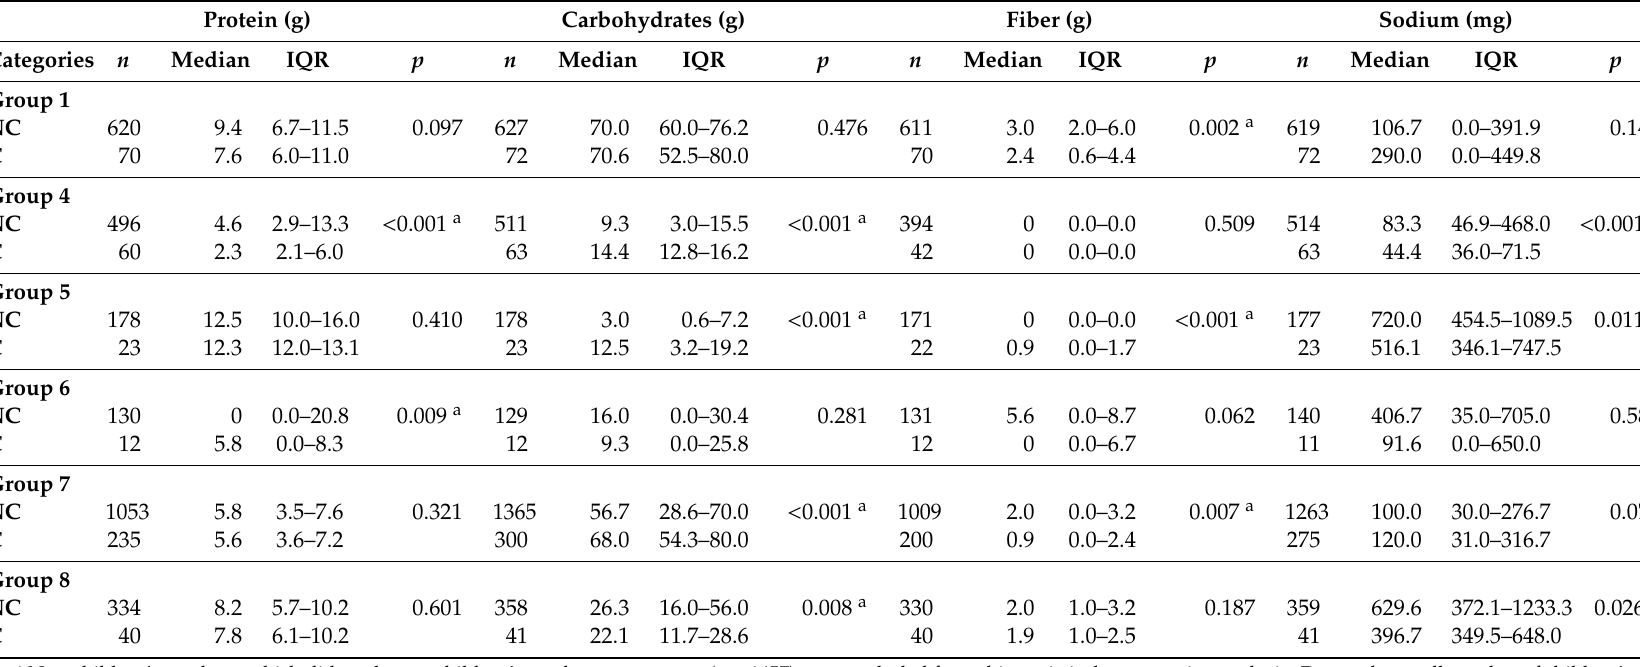
Table 4. Comparison of protein, carbohydrate, fiber, and sodium content per 100 g children’s (C) ( n = 535) and non-children’s (NC) ( n = 3628) food products.* Protein (g) Carbohydrates (g) Fiber (g) Sodium (mg)